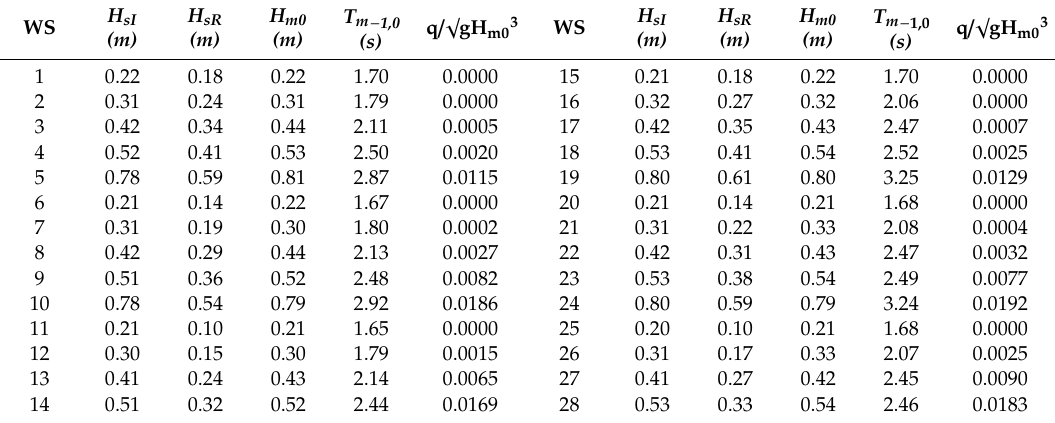
Table 4. Test results for cross-section type B.